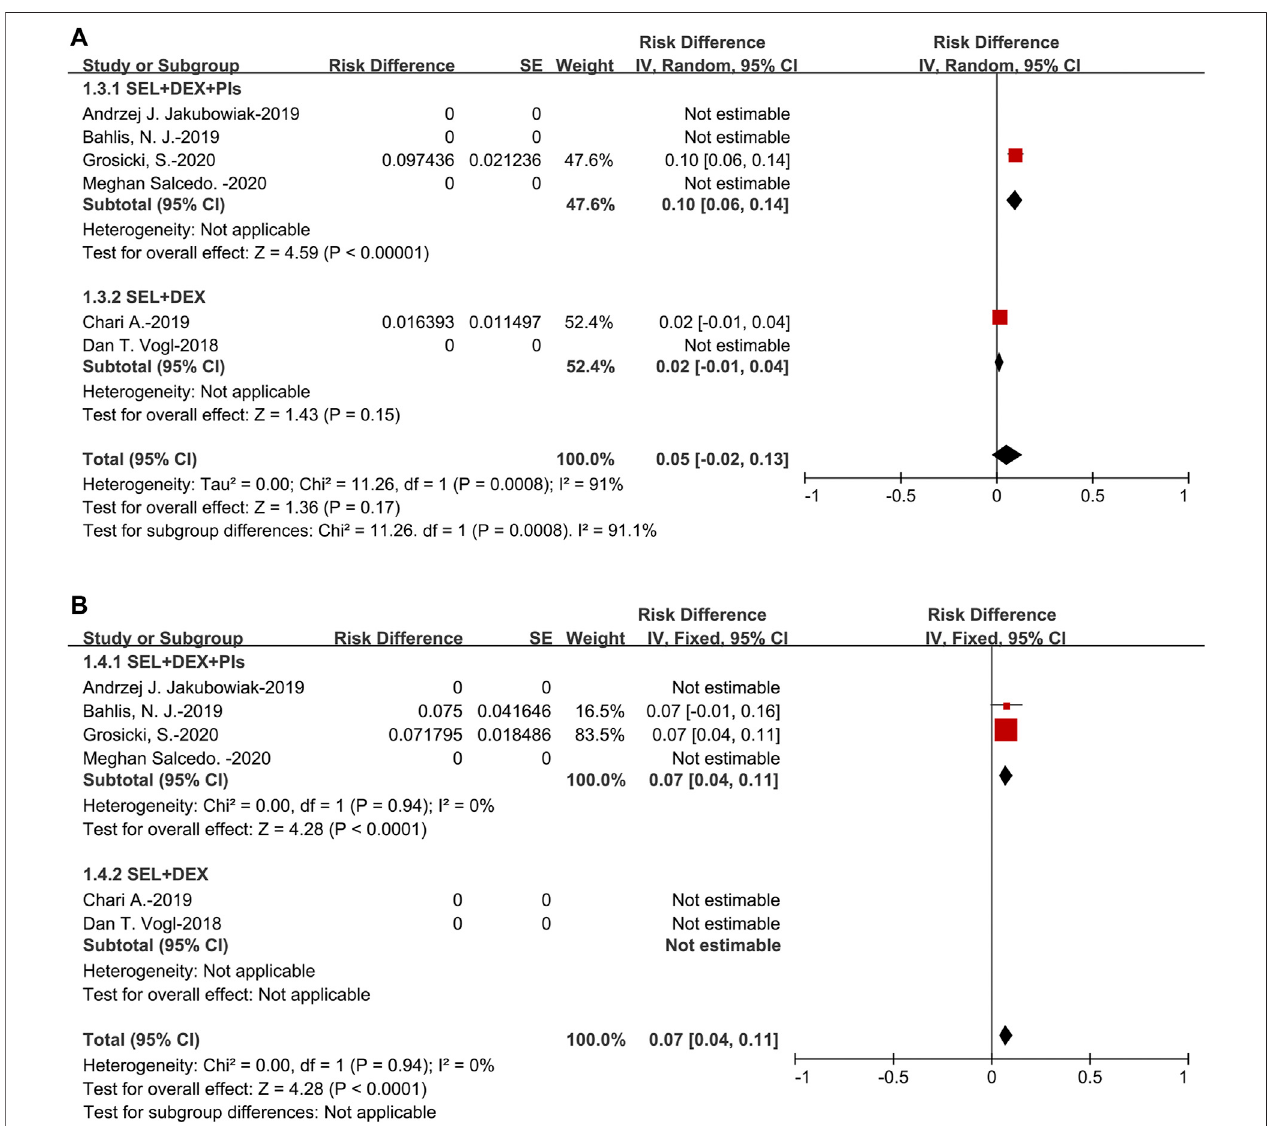
FIGURE 3 | The forest plot of pooled (A) sCR, and (B)